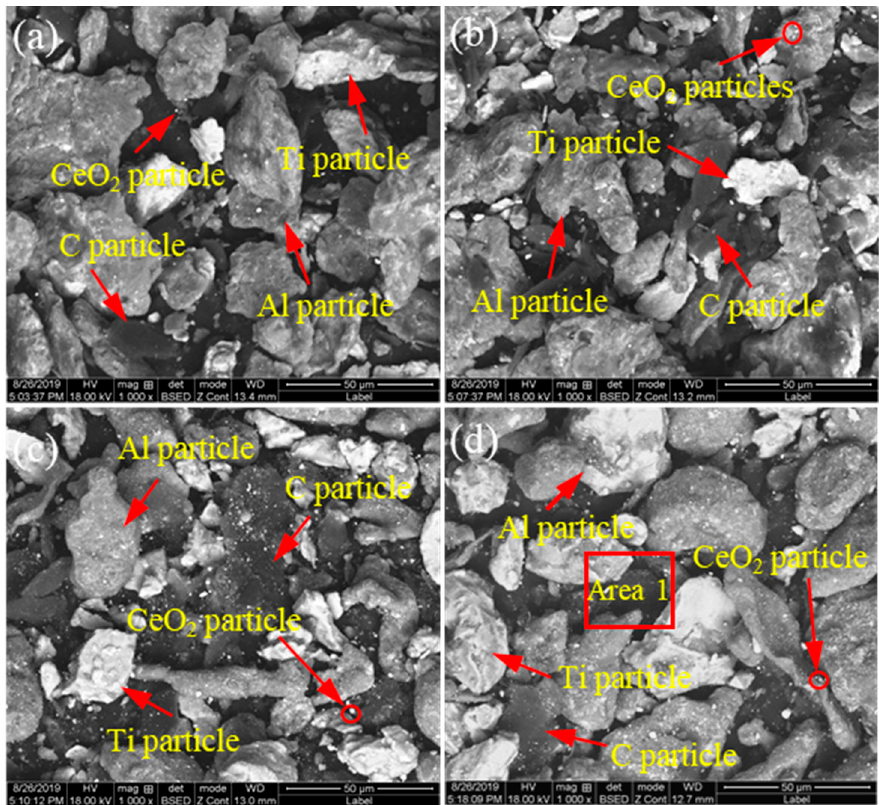
Figure 2. The microstructure of the mixed powders (Al, Ti, C and CeO 2 ) with different CeO 2 size after ball milling: ( a ) 30 nm; ( b ) 50 nm; ( c ) 1 µ m; ( d ) 2–4 µ